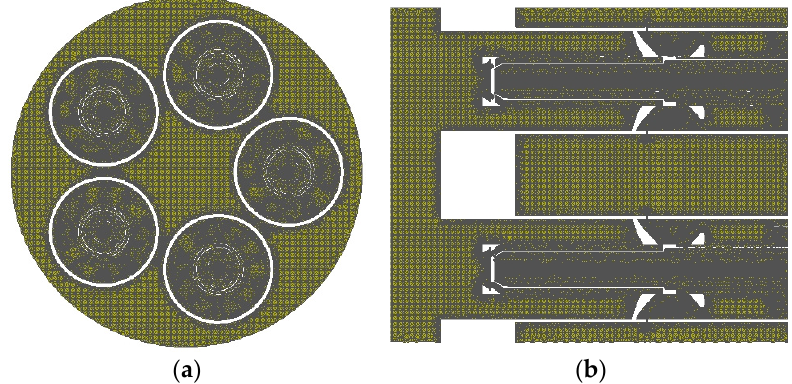
Figure 7. Mesh generation. ( a ) The burner inlet section; ( b ) The head of combustor.